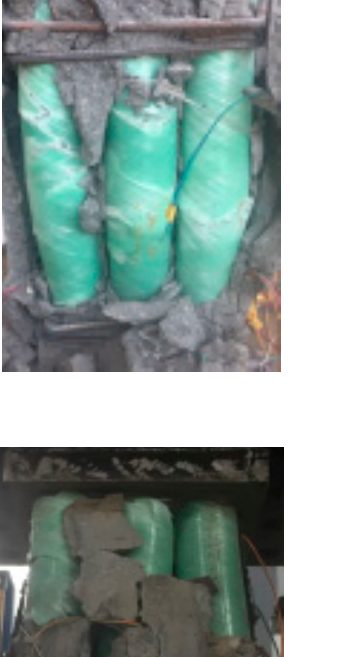
( b ) Figure 10. Finite element model of T8: ( a ) unconfined concrete and ( b ) fiber reinforced polymer confined concrete cores (FCCCs). 5.2. Comparison of the Simulation Results